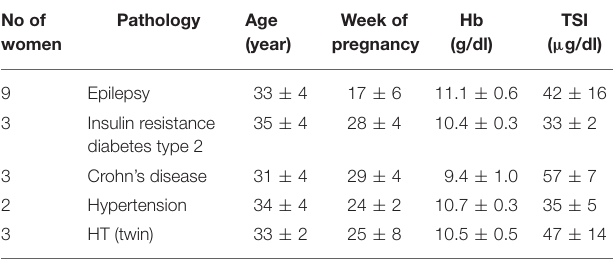
TABLE 2 | Demographics and baseline of hemoglobin and total serum iron mean values ± SD of pathological pregnancies affected by anemia enrolled at different trimesters of gestation.